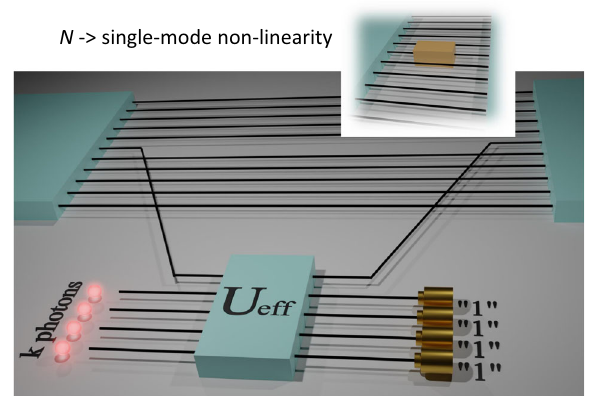
Fig. 2 Linear optics simulation of non-linear Boson Sampling. Scheme for linear optics simulation of non-linear Boson Sampling with a single-mode nonlinearity N on mode x between two Haar- random linear unitaries W and V . Mode x after linear transformation W is injected in the fi rst port of a ( k + 1)-mode linear-optical gadget described by unitary U eff , whose other input ports are injected with k single photon states ( k ≤ n ). Detection of one photon in each of the k auxiliary modes of the gadget heralds a successful simulation of the single-mode non-linearity in mode x of the original interferom- eter (see